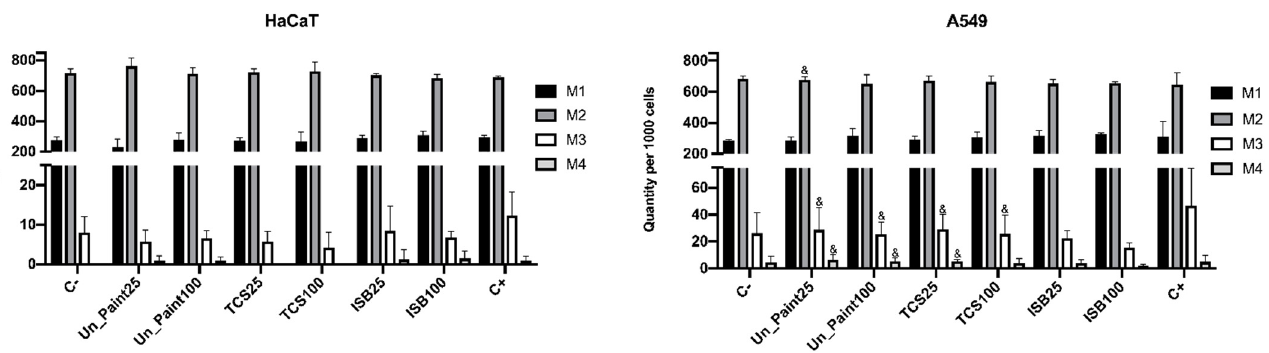
Figure 7. Nuclear division index (NDI) of HaCaT ( left ) and A549 ( right ) cell lines, after exposure to extracts of the samples (in the x axis) Un_Paint, TCS or ISB extracts for 24 h. C- negative control (complete medium), C+ positive control (MMS 800 µM solution). The values are expressed as mean ± standard deviation. The statistical significance of samples compared to C- is represented by * (One- way ANOVA; p < 0.05). The statistical significance of samples compared to Un_Paint is represented by # (Two-way ANOVA; p < 0.05). The statistical significance of the extract on A549 cells compared to the same extract, in the same concentration, on HaCaT cells is represented by & (Two-way ANOVA; p < 0.05).